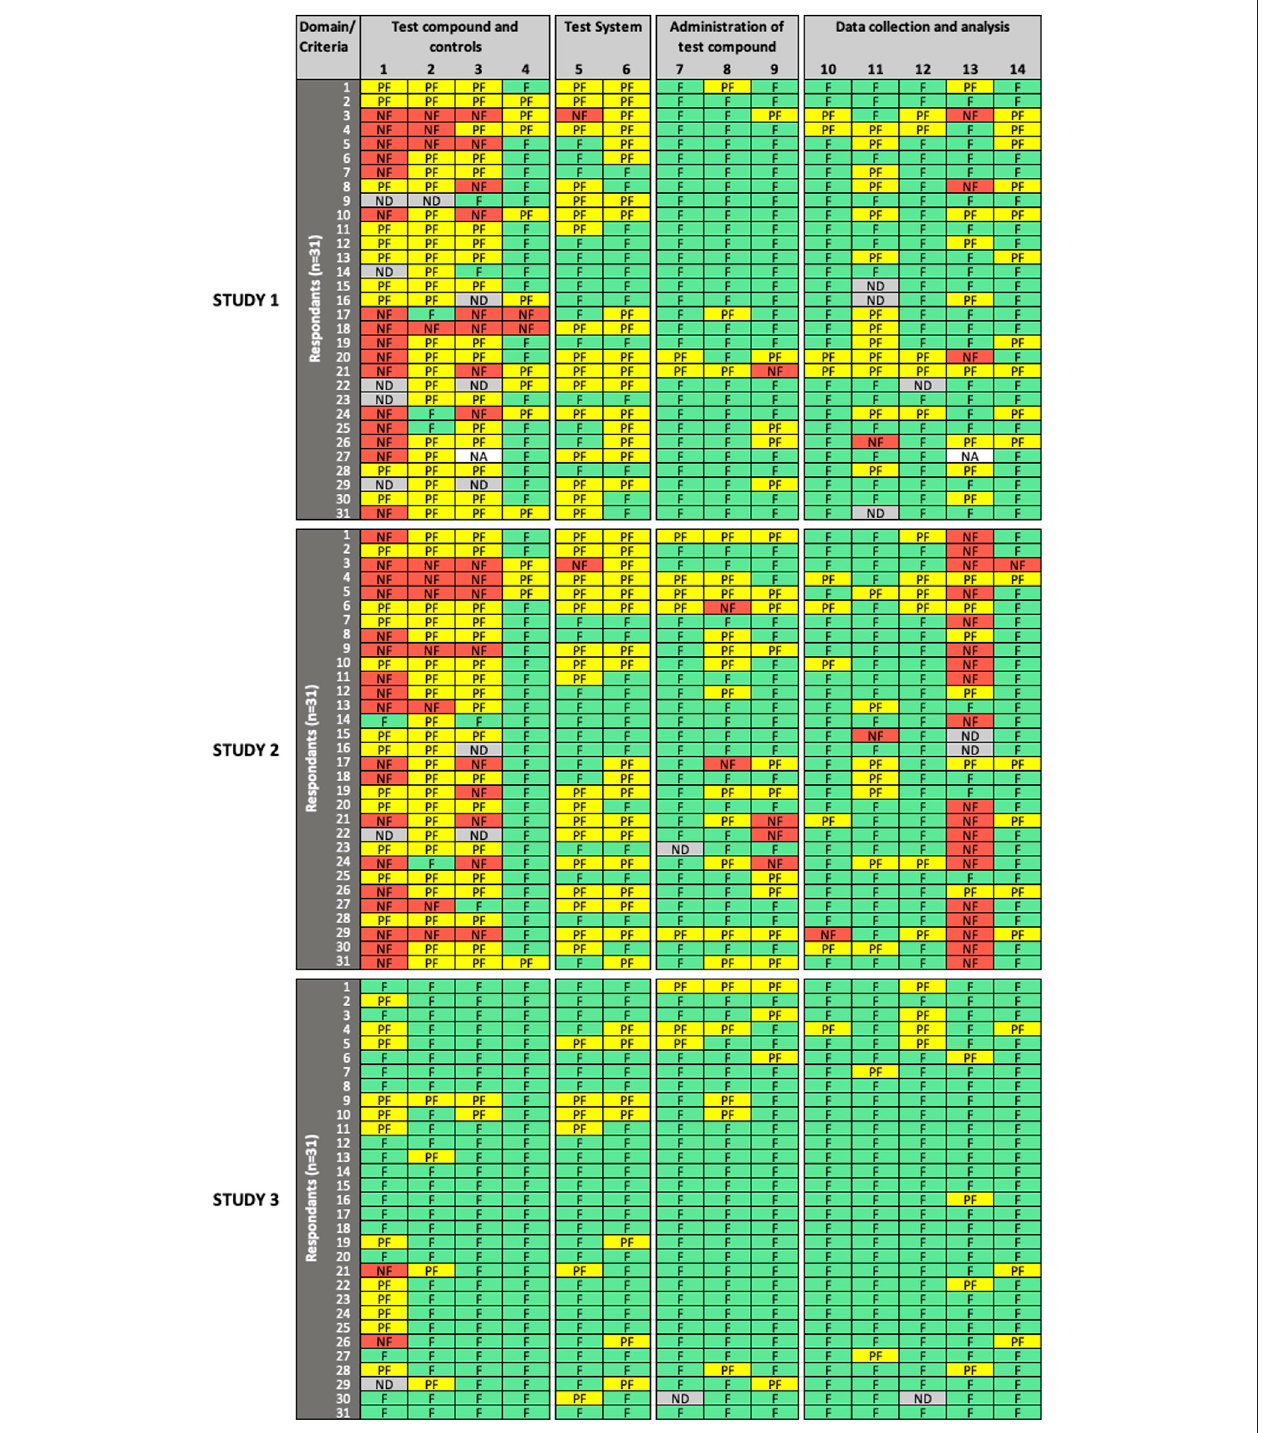
FIGURE 2 | Results of the expert test round evaluations of methodological quality (MQ) of the three in vitro studies ( n (cid:1) 31 participants). Each row represents the evaluation by one participant; columns represent individual criteria. Green cells indicate criteria judged as “ ful fi lled ” (F) , yellow cells indicate criteria judged as “ partially ful fi lled ” (PF) , red cells indicate criteria judged as “ not ful fi lled ” (NF) , grey cells indicate criteria left as “ not determined ” (ND) , and white cells indicate criteria removed by the participant as “ not applicable ” (NA) . MQ refers to the scienti fi c soundness and appropriateness, including sensitivity, of the study design and methods used.